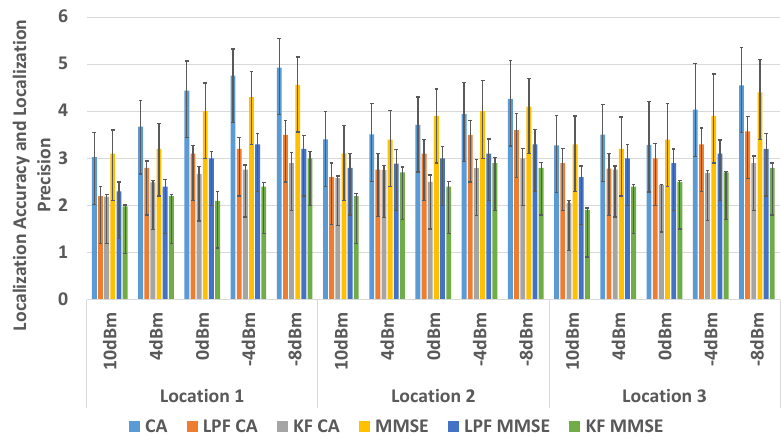
Figure 14. Comparison in Environment